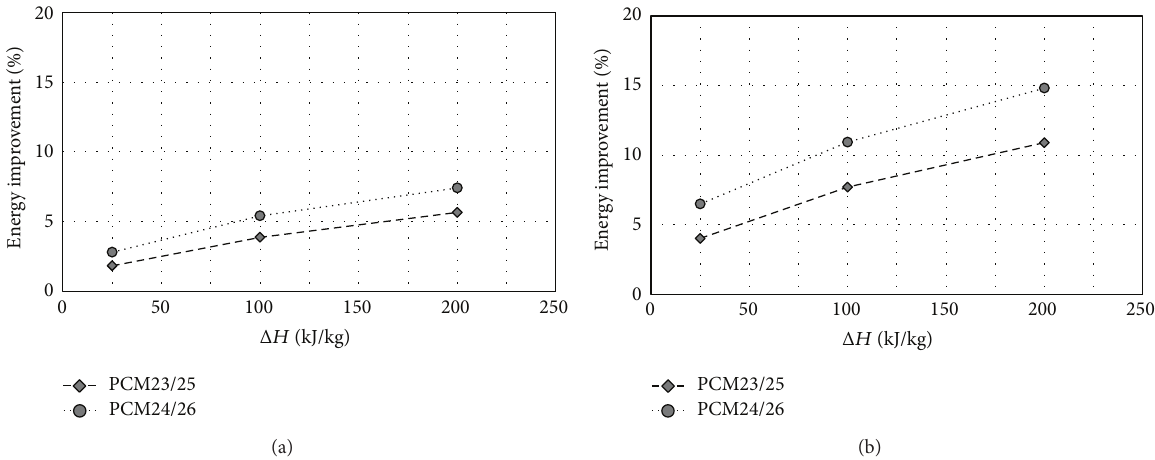
Figure 7: Energy savings analysis of the inside of an office cell placed in (a) Lisbon and (b)